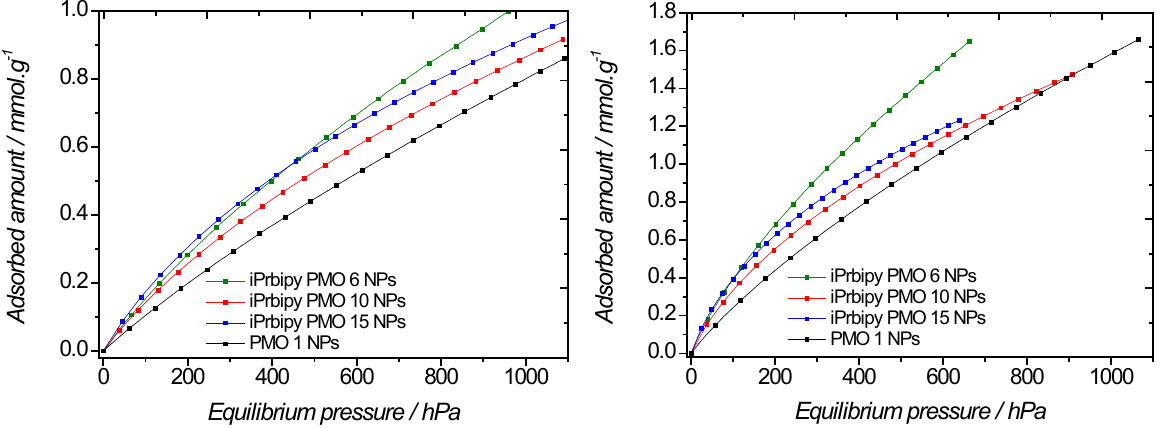
Figure 11. Evolution of the CO 2 adsorption of BTEE/iPrbipyridine PMO NPs with different bipyri- dine molar fractions versus absolute pressure at 298 K ( left ) and 273 K ( right ). Table 3. CO 2 adsorption capacity (expressed as mmol·g −1 ) at 10 5 Pa for the BTEE/bipyridine PMO NPs.